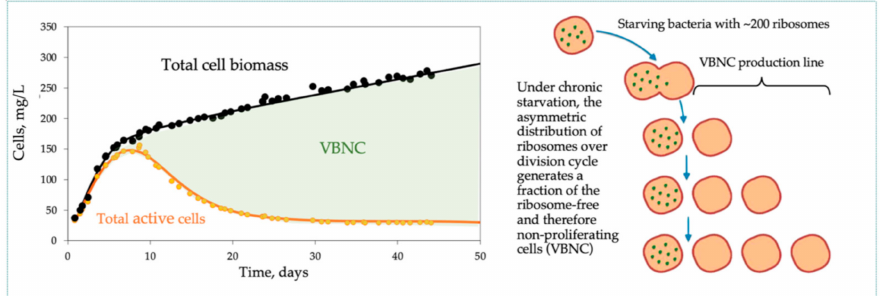
Figure 4. Near-zero growth of Pseudomonas putida F1 in a continuous dialysis culture [28]. Left : Growth dynamics and the formation of VBNC (green shaded area). Right : The hypotheti- cal mechanism explaining VBNC formation. Similar dynamic patterns were observed in a continuous dialysis culture and in a chemostat with cell recycling. Reprinted with permission from [28]. Copy- right (2015) the Society for Applied Microbiology, London,